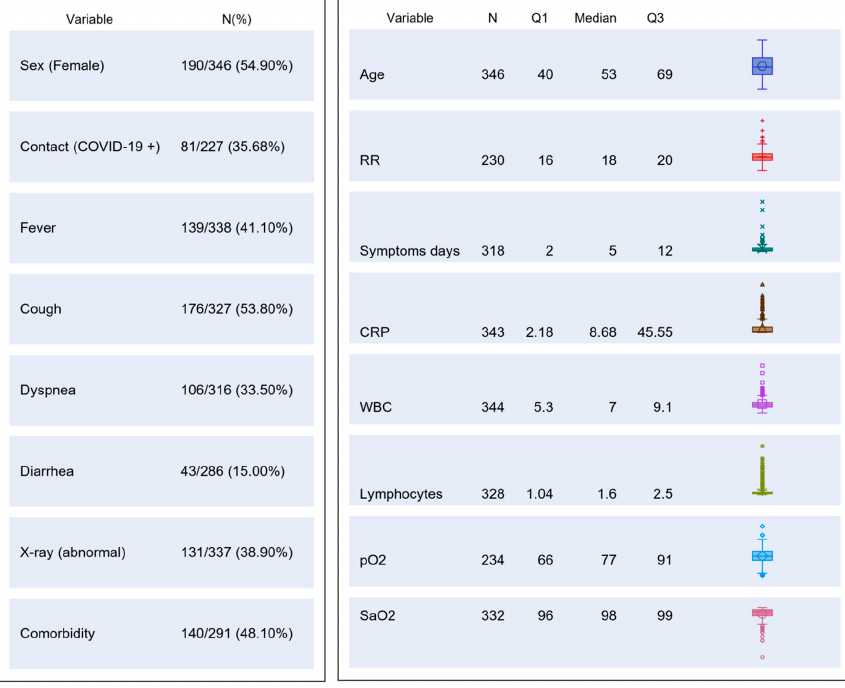
Figure 2. Table chart on main demographic, clinical, laboratory and imaging characteristics of the study population. CRP, C reactive protein; RR, respiratory rate; WBC, white blood cells; pO2, partial pressure of oxygen; SaO2, oxygen saturation. Diagnostics 2020 , 10 , x FOR PEER REVIEW